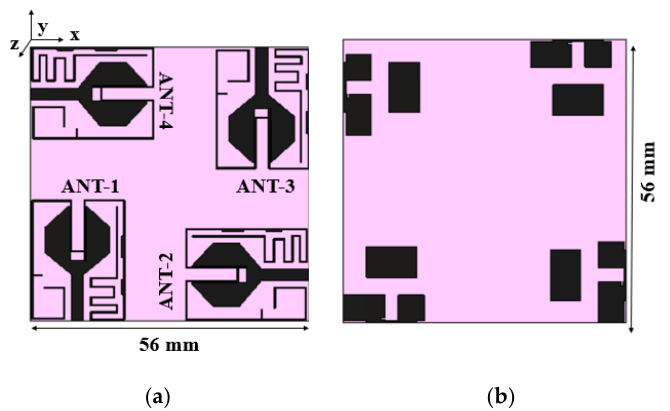
Figure 7. Layout of the MIMO antenna with unconnected ground planes: ( a ) front view, ( b ) rear view.